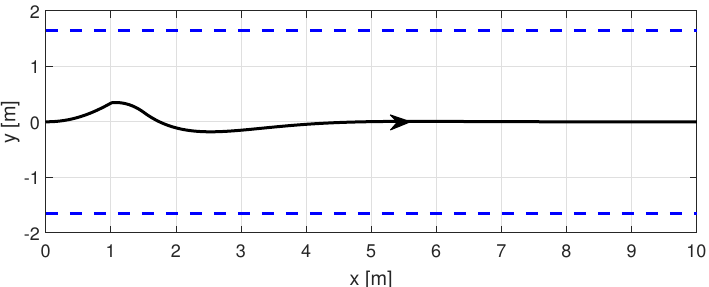
Figure 11. Vehicle trajectory of the proposed method